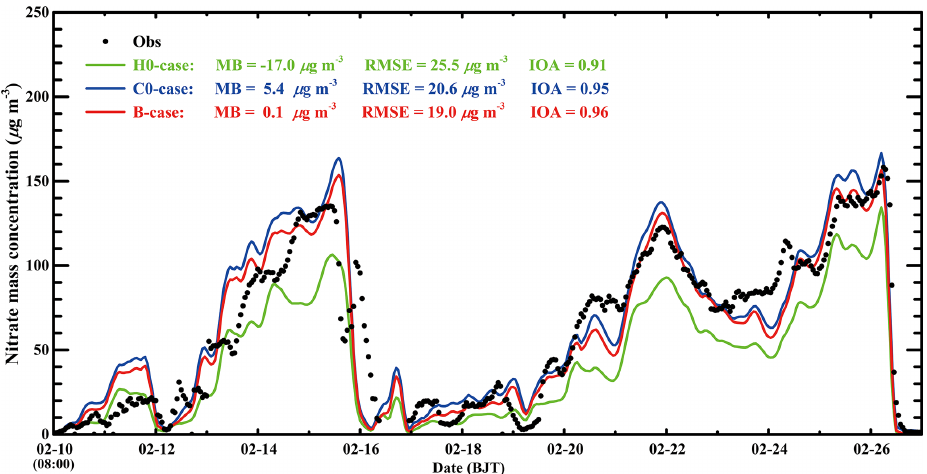
Figure 8. Temporal variations in observed (black dot) and simulated (green line: H0-case; blue line: C0-case; red line: B-case) nitrate concentrations at the CRAES site in Beijing from 10 to 27 February